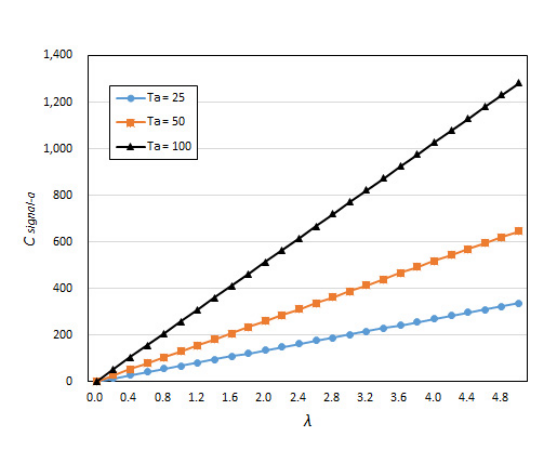
Figure 11. Ratio of signaling overhead (Proxy-AAA / traditional ).